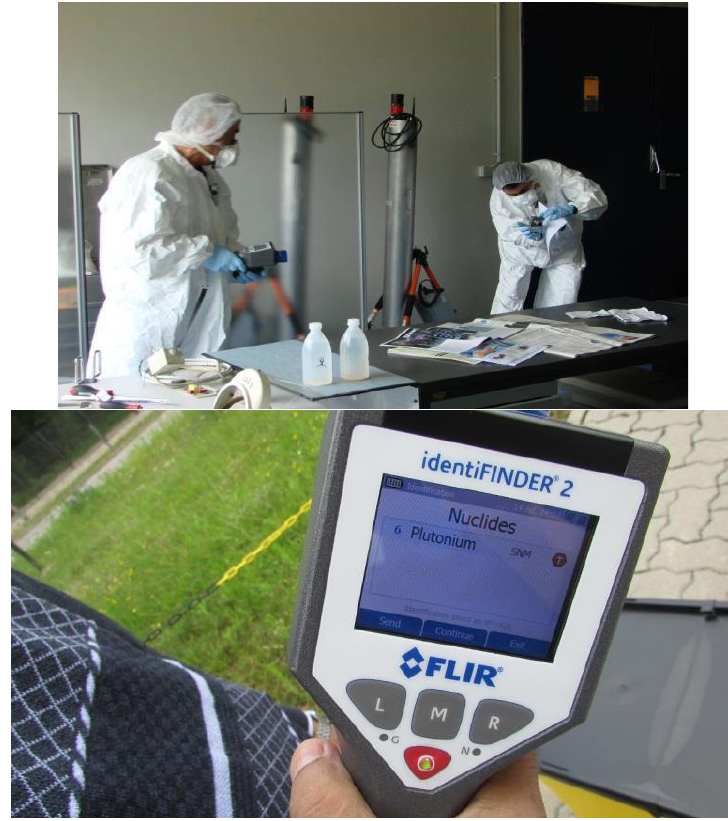
Figure 2: tabletop and in-field exercises to both find nuclear materials and implement a proper radiological crime scene management. © European Commission (2016, JRC